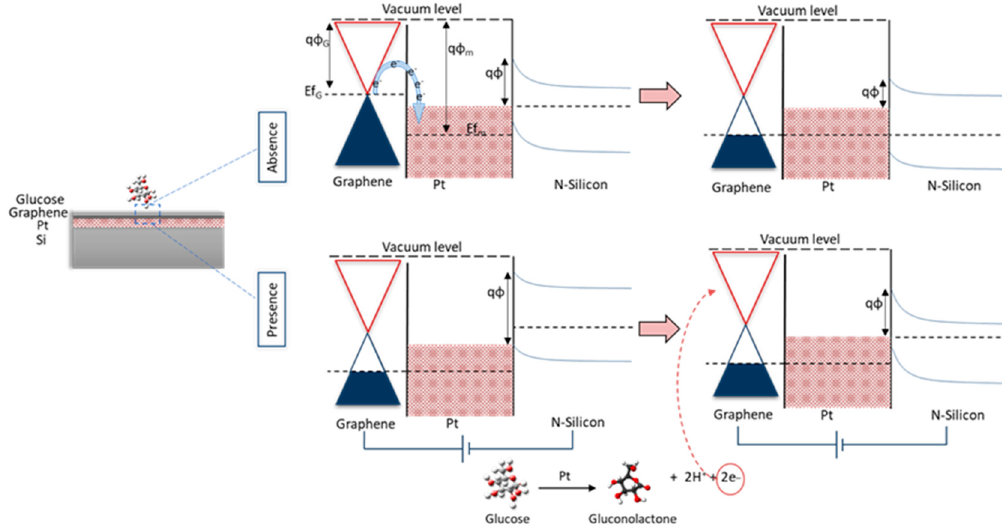
Figure 1. Graphical scheme for the working principle of the device.